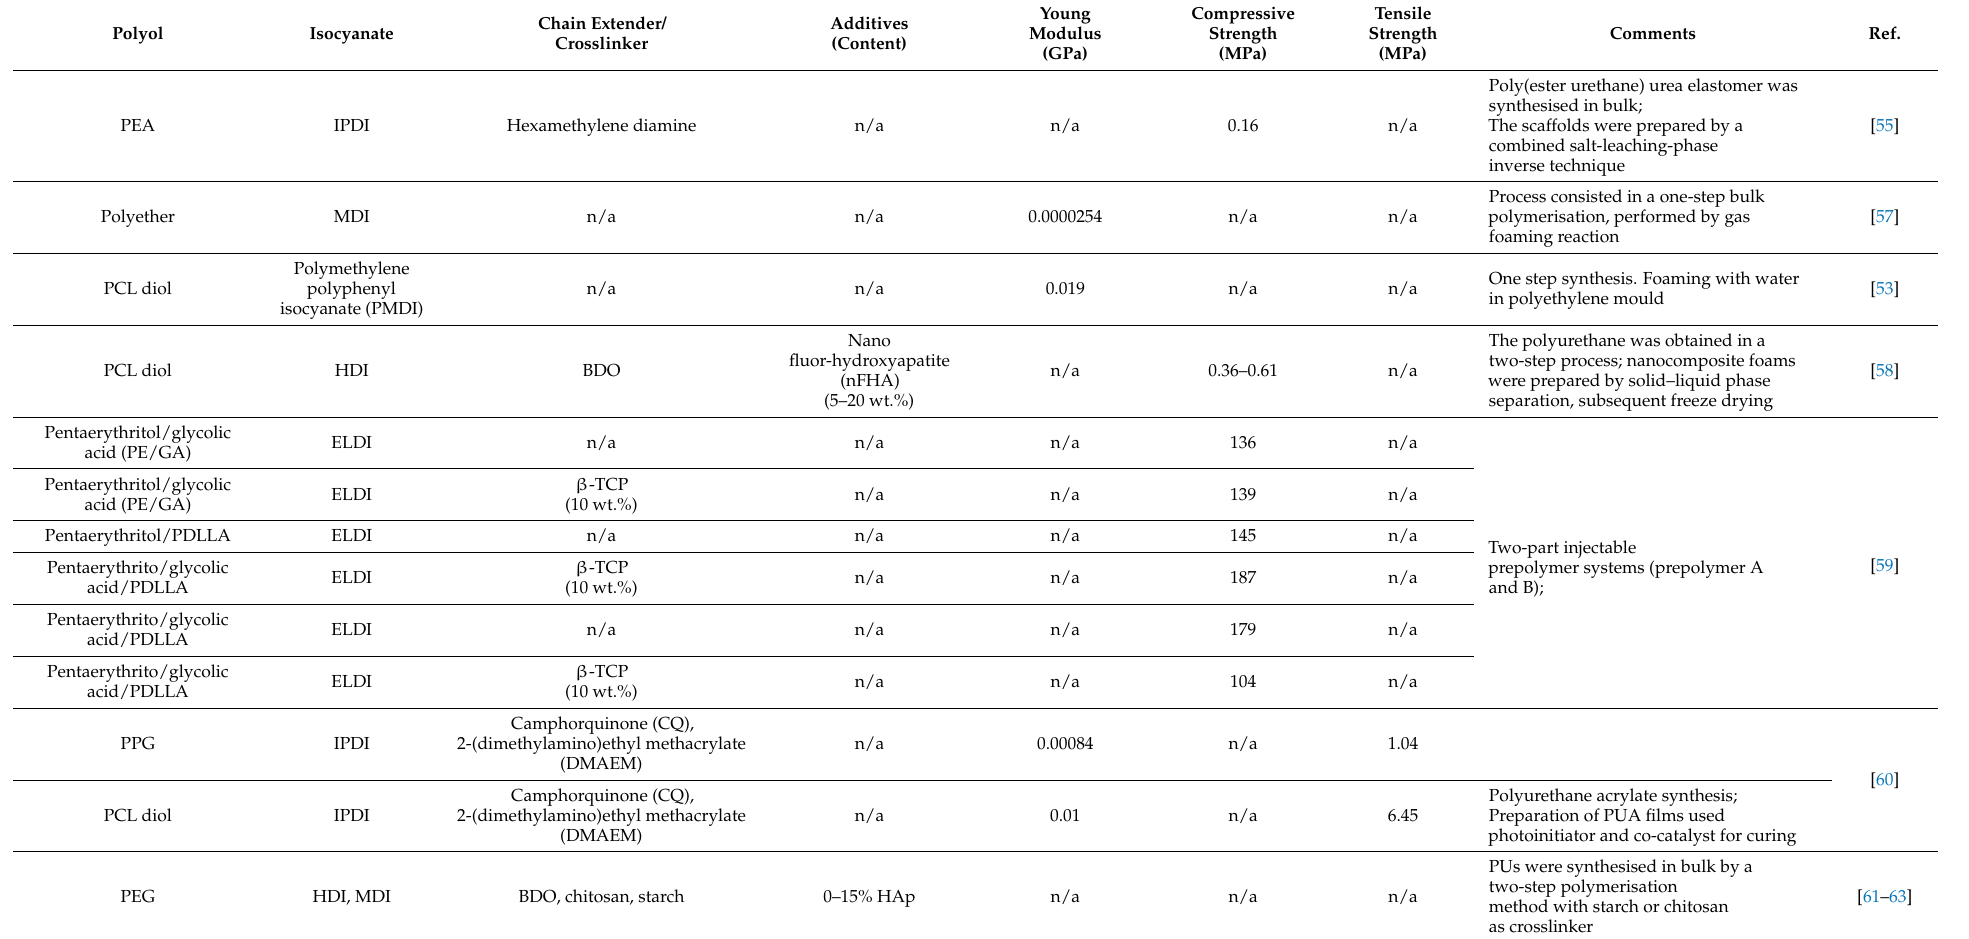
Table 2. Polyurethanes investigated for biomedical